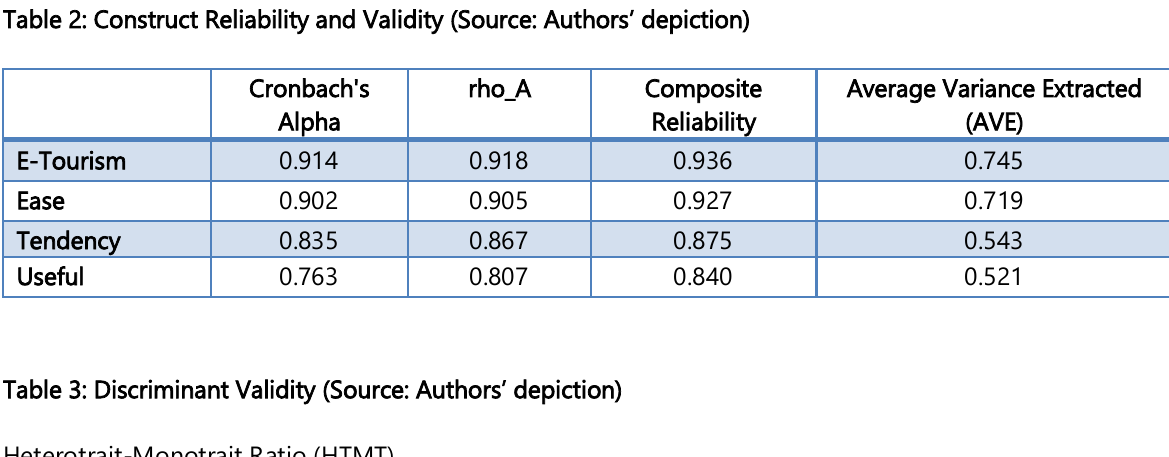
Table 2: Construct Reliability and Validity (Source: Authors‘ depiction)